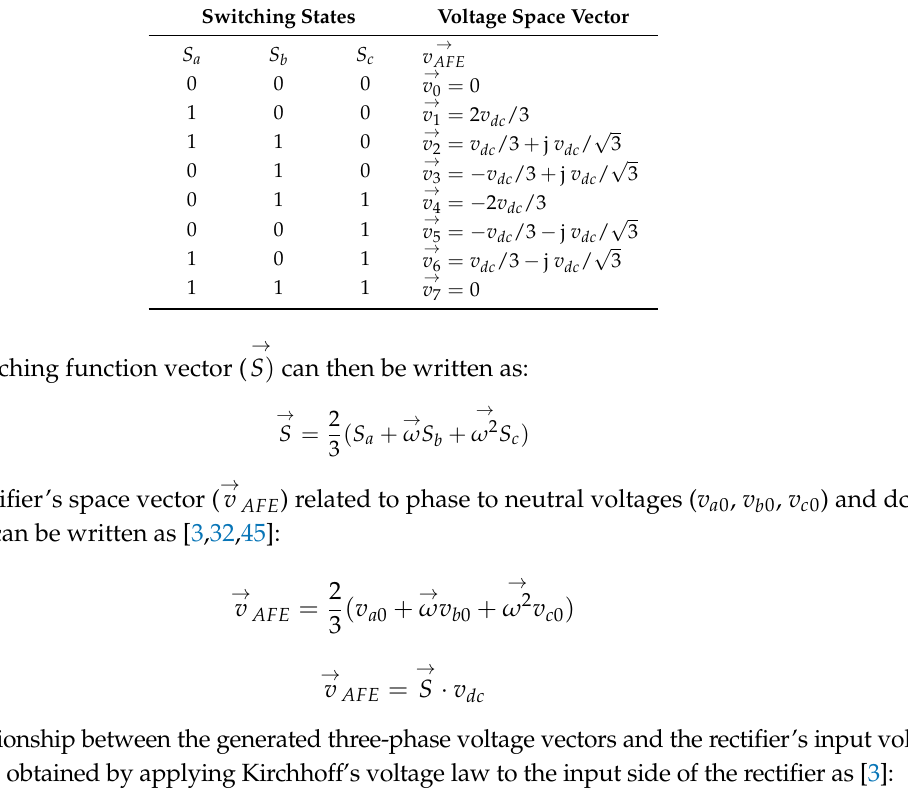
Table 1. Switching states and voltage space vectors of three phase voltage source. Switching States Voltage Space